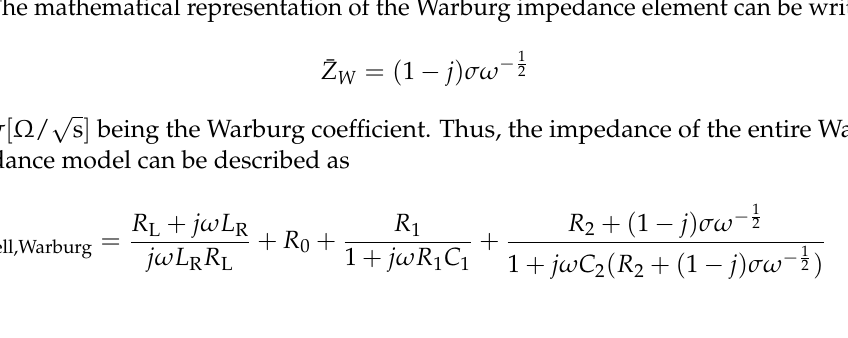
Figure 2. Dynamic battery model with a Warburg impedance